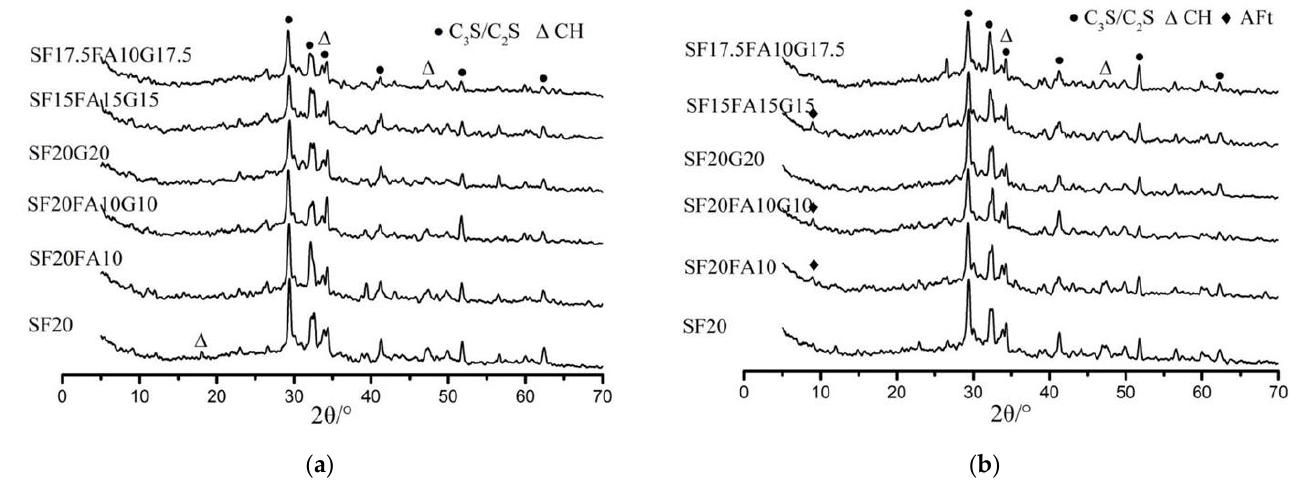
Figure 5. XRD of EUHPC at the age of 7 days and 28 days under steam curing: ( a ) XRD at the age of 7 days; ( b ) XRD at the age of 28 days.